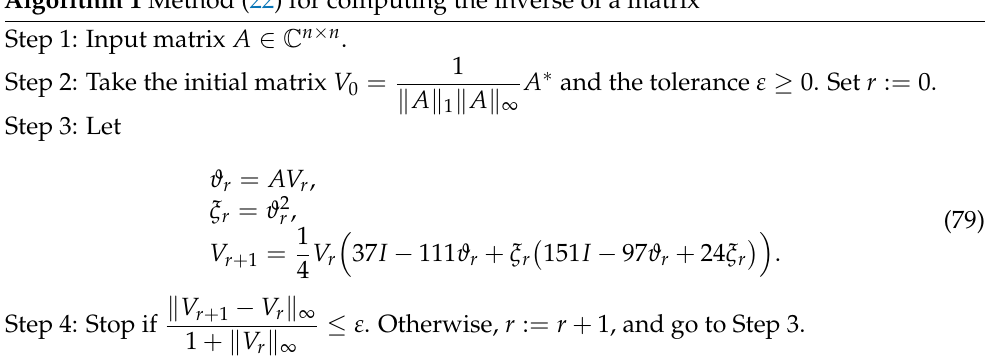
Algorithm 1 Method (22) for computing the inverse of a matrix